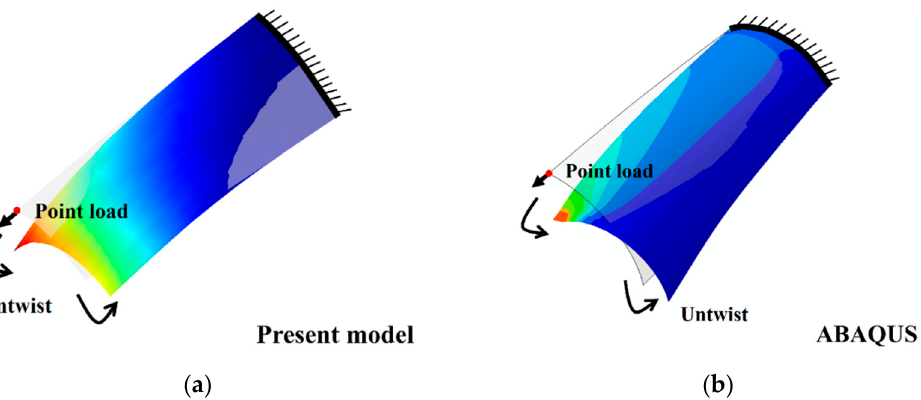
Figure 13. 3D structural configurations of a 30° pre-twisted cantilever with 90° arc profile cross sections and edge point load: ( a ) present results; ( b ) ABAQUS results.